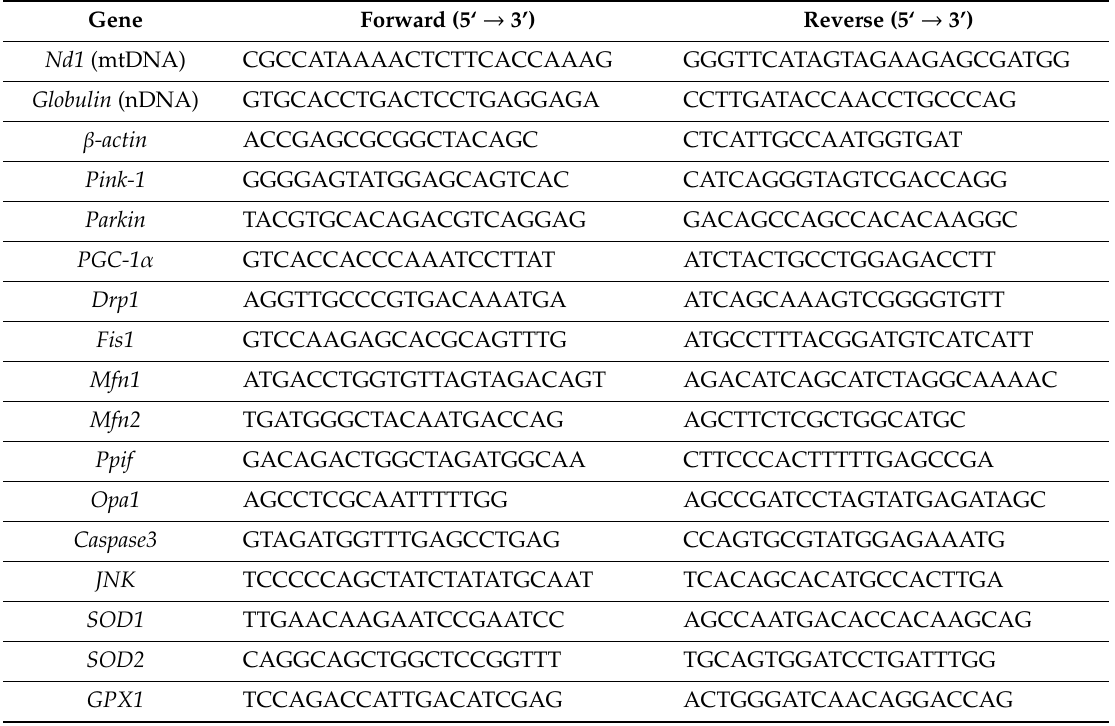
Table 1. Human-specific primer sequences for quantitative real-time polymerase chain reaction